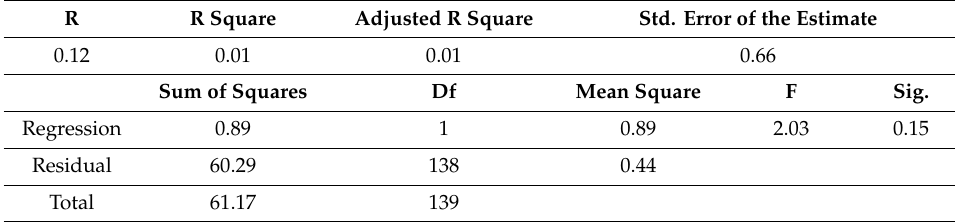
Table 12. Model Summary (Community planning Potential), ANOVA (Community planning Potential). R R Square Adjusted R Square Std. Error of the